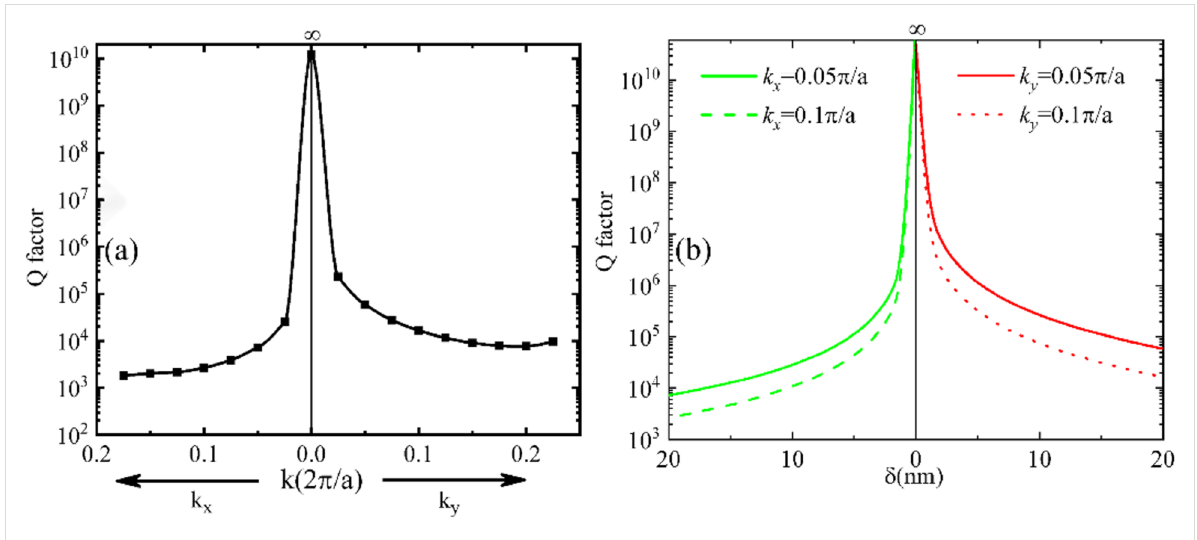
Figure 3: (a) Q-factors along the dispersion curves of QGMs in Figure 2. (b) Q-factor as a function of the level of perturbation at two points along two directions.